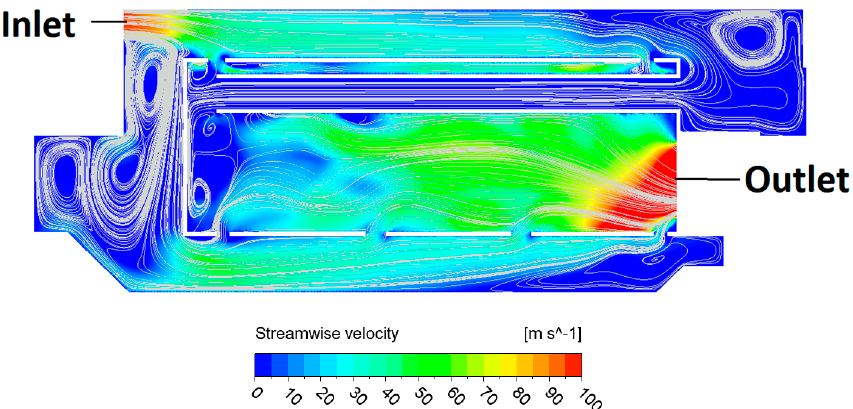
Figure 6. Streamwise velocity contour at the combustion chamber cross-section